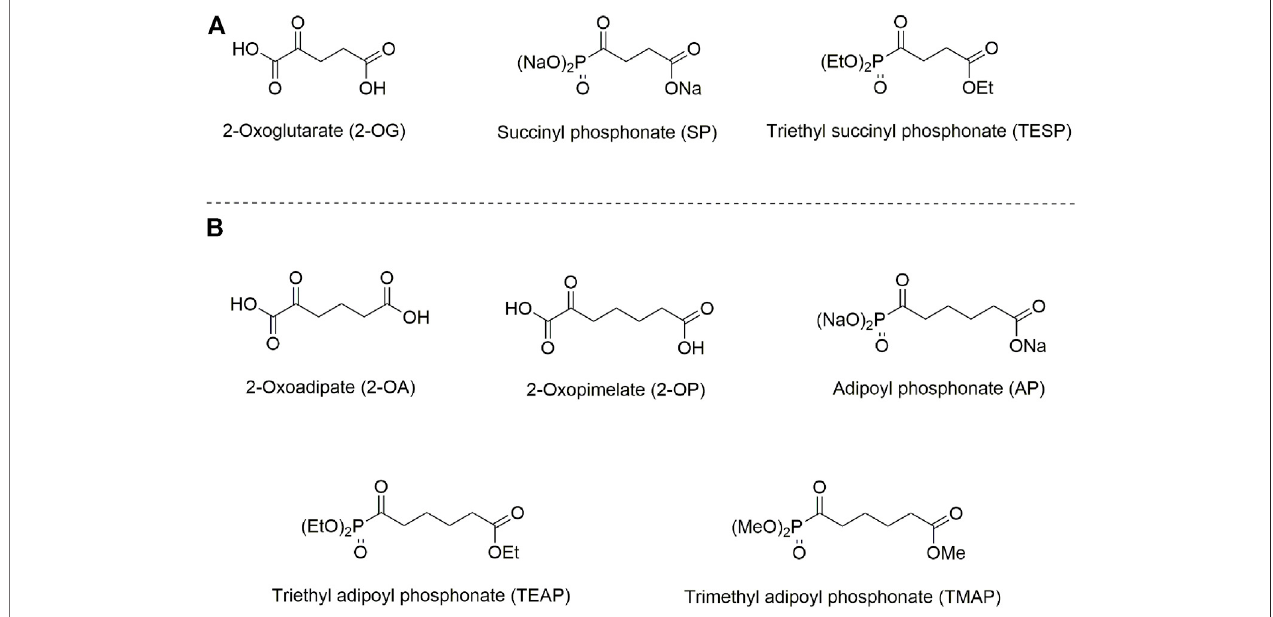
FIGURE 1 | Structures of 2-oxo acids, their phosphonate analogs, and esters, used in this study. (A) 2-Oxoglutarate and its phosphonate analog succinyl phosphonate (SP) and triethyl succinyl phosphonate (TESP). (B) 2-Oxoadipate and its homolog 2-oxopimelate and the phosphonate analog of 2-oxopimelate adipoyl phosphonate (AP), triethyl adipoyl phosphonate (TEAP), and trimethyl adipoyl phosphonate